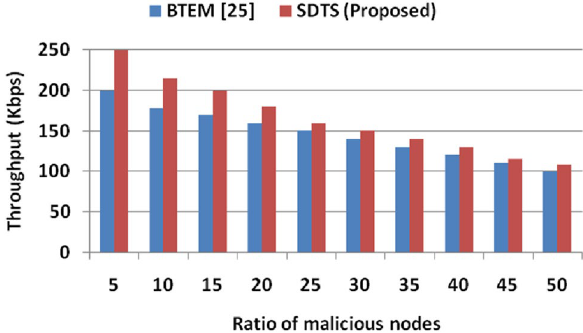
Figure 10. Ratio of malicious nodes vs.